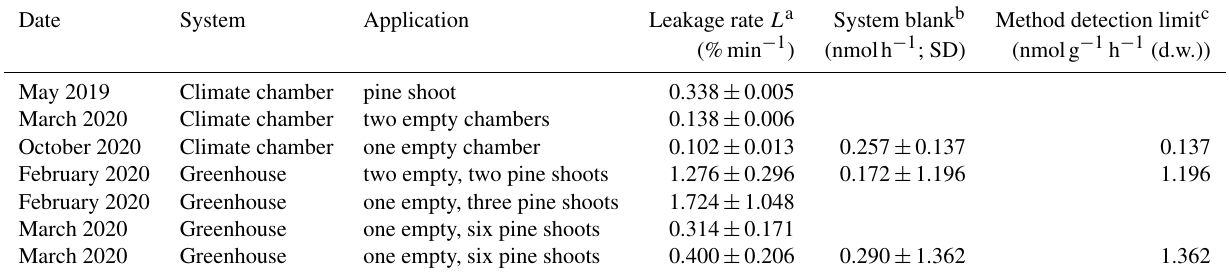
Table 2. Observed chamber leakage rates, system blanks, and method detection limits.